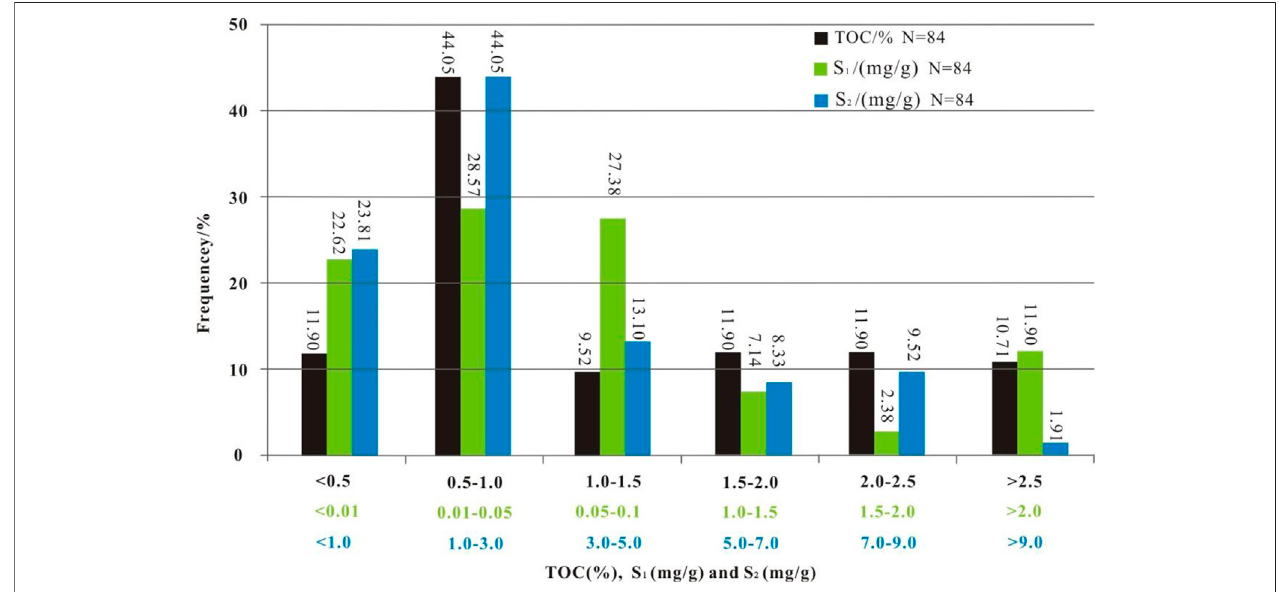
FIGURE 4 | TOC, S 1 (mg/g) and S 2 (mg/g) histogram. There are three groups of data scopes, color-coded: black, ranges of TOC data; green, ranges of S 1 data; blue, ranges of S 2